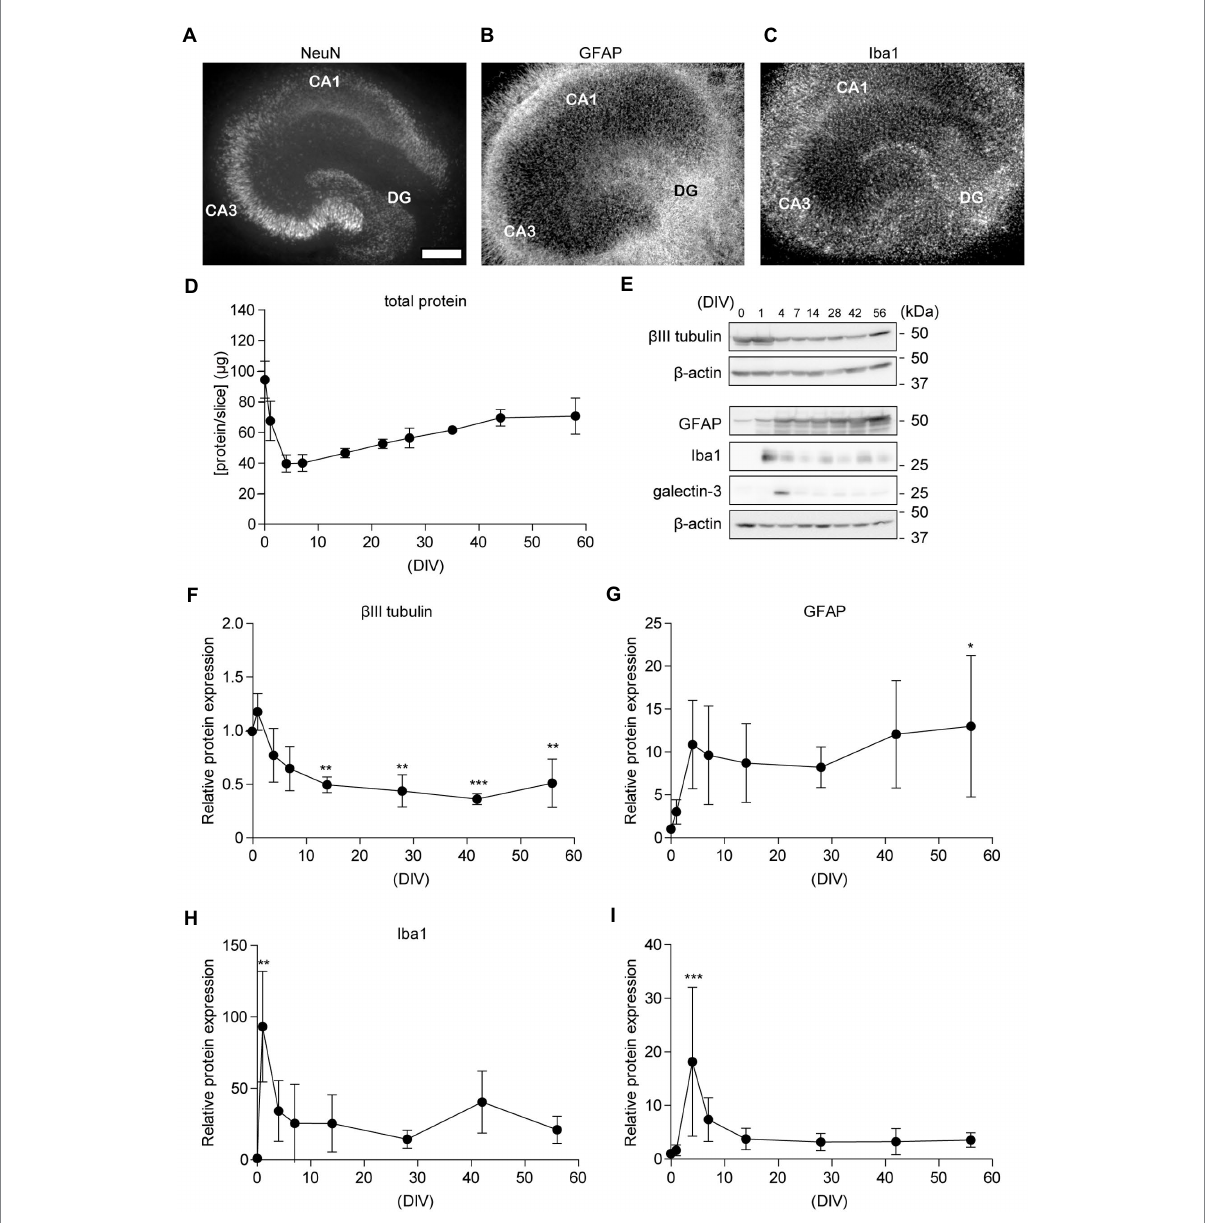
FIGURE 2 Chronological analysis of neuronal cells in cultured hippocampal slices. (A–C) Immunofluorescence staining of cultured hippocampal slices antibodies against NeuN (A) , GFAP (B) , and Iba1 (C) . CA1, Cornu Ammonis 1; CA3, Cornu Ammonis 3; DG, dentate gyrus. The scale indicates 500 μ m. (D) Quantitative analysis of total protein in the lysate from four acute slices (0 days in vitro ; DIV) or cultured slices (1–56 DIV). (E–I) Immunoblotting analysis of hippocampal slices with antibodies against β III tubulin (F) , GFAP (G) , Iba1 (H) , and galectin-3 (I) . Each point (filled circle) denotes relative protein expression which was normalized to β -actin and relative to a 0 DIV (acute slice) sample. Full-length blots: Supplementary Figures S4, S5. Statistical significance was tested by one-way ANOVA, and pairwise comparison was performed according to Tukey–Kramer multiple comparison test. NS; p > 0.05; *; p < 0.05; **; p < 0.01; ***; p < 0.001, (vs. 0 DIV). Data are presented as mean ± SD, based on four independent experiments ( n =